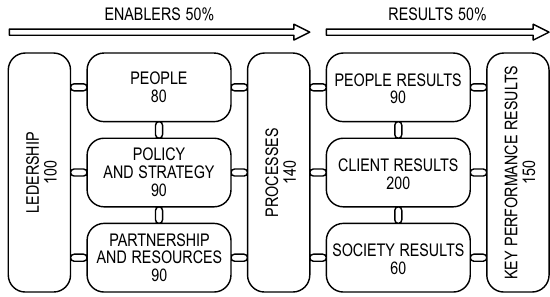
Fig. 1. EFQM Excellence